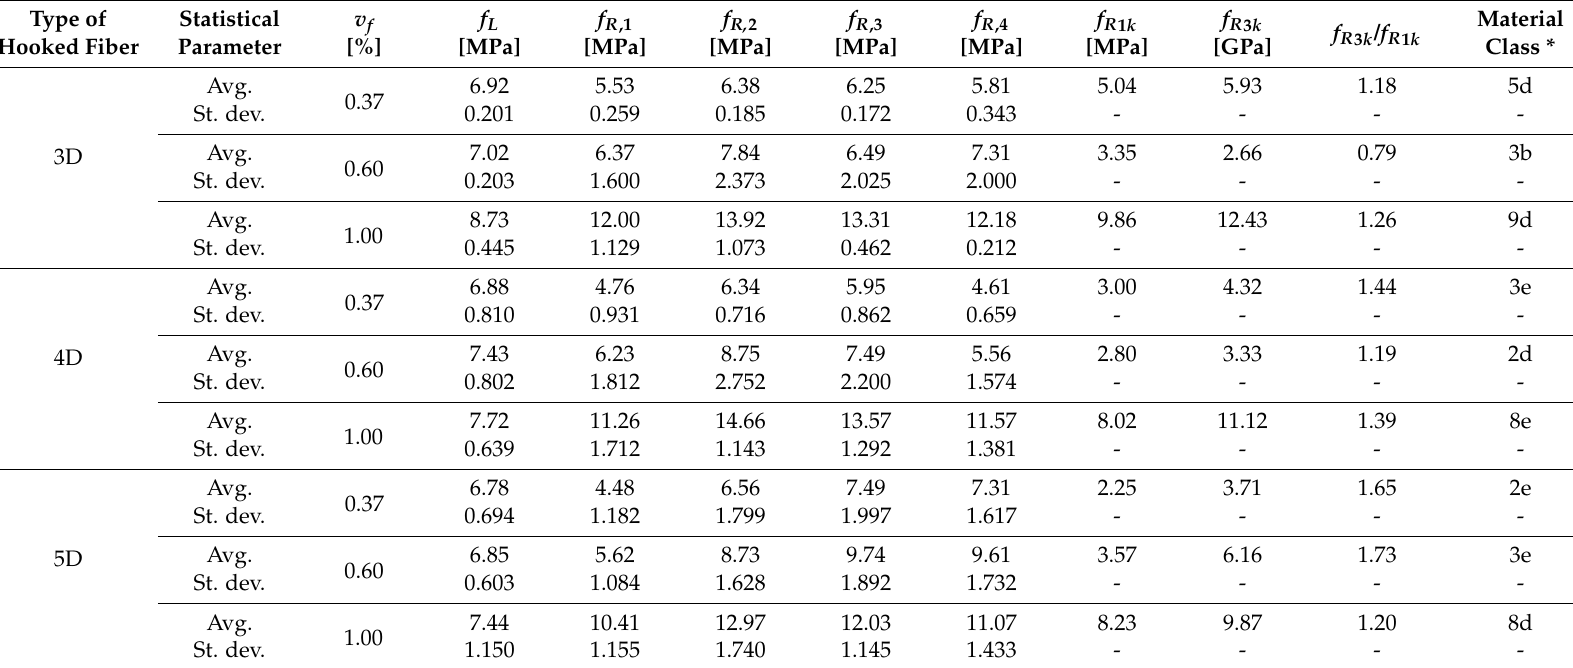
Table 2. Summary of three-point bending test results as per EN 14651 standard